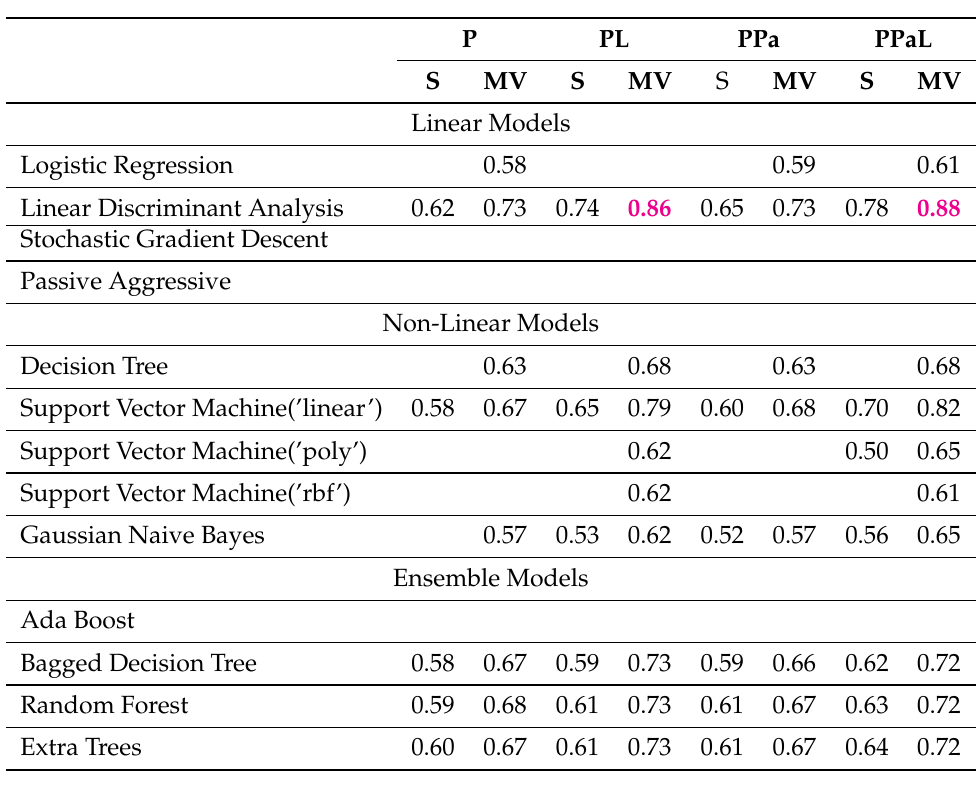
Table 1. Mean of 9 users, Algorithms vs Accuracy of CLASSIC features. 18 gestures without (S) and with majority voting (MV) to stabilize the